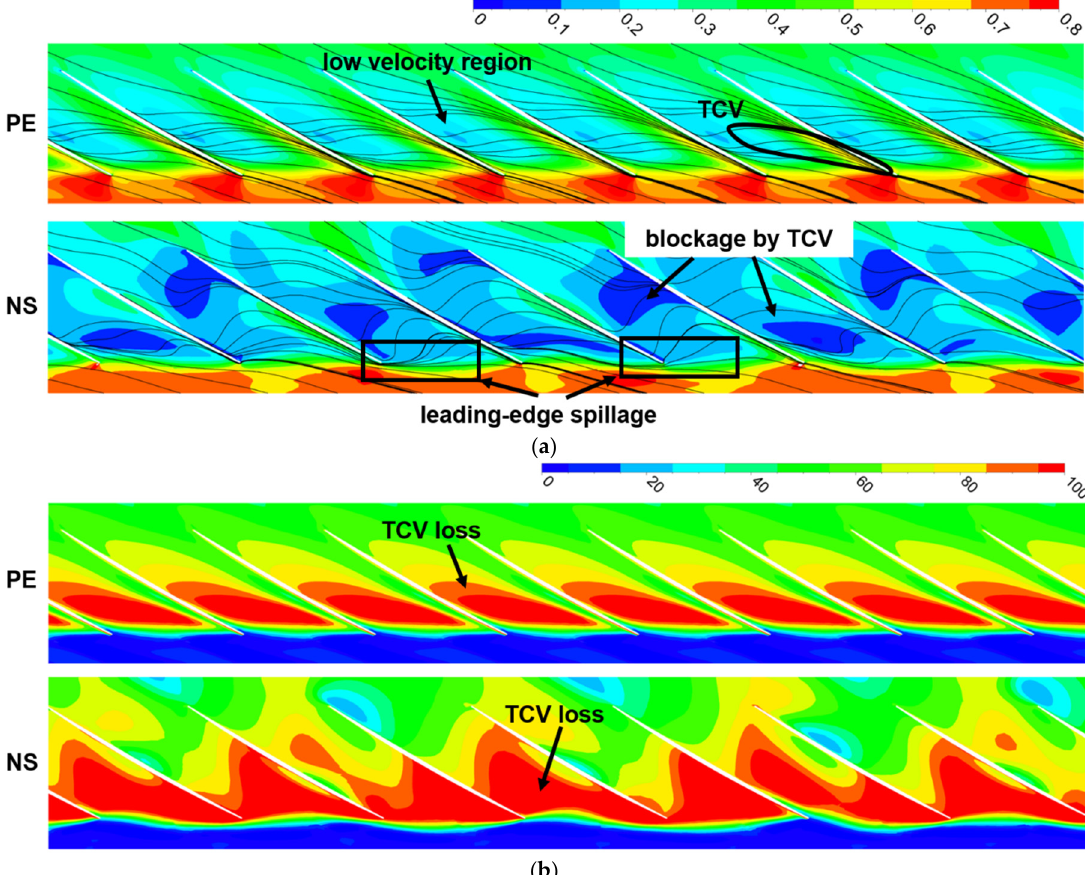
Figure 20. Time-averaged results at 96% of span. ( a ): Relative Mach contours with streamline of relative velocity. ( b ): Entropy contours (J/(kg K)).